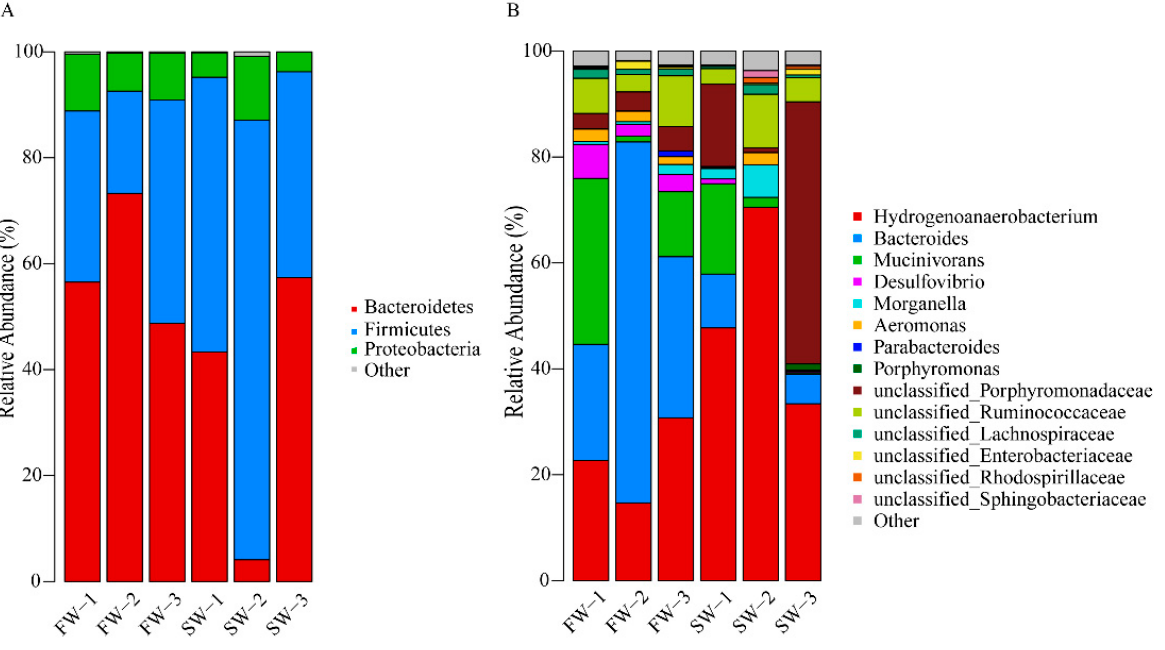
Figure 2. ( A ) Microbial community bar plot on the phylum level. Relative abundance of bacterial genera in each sample. ( B ) Microbial community barplot on the genus level. Relative abundance of bacterial genera in each sample. Table 2. Relative abundance of dominant phyla in FW and SW.